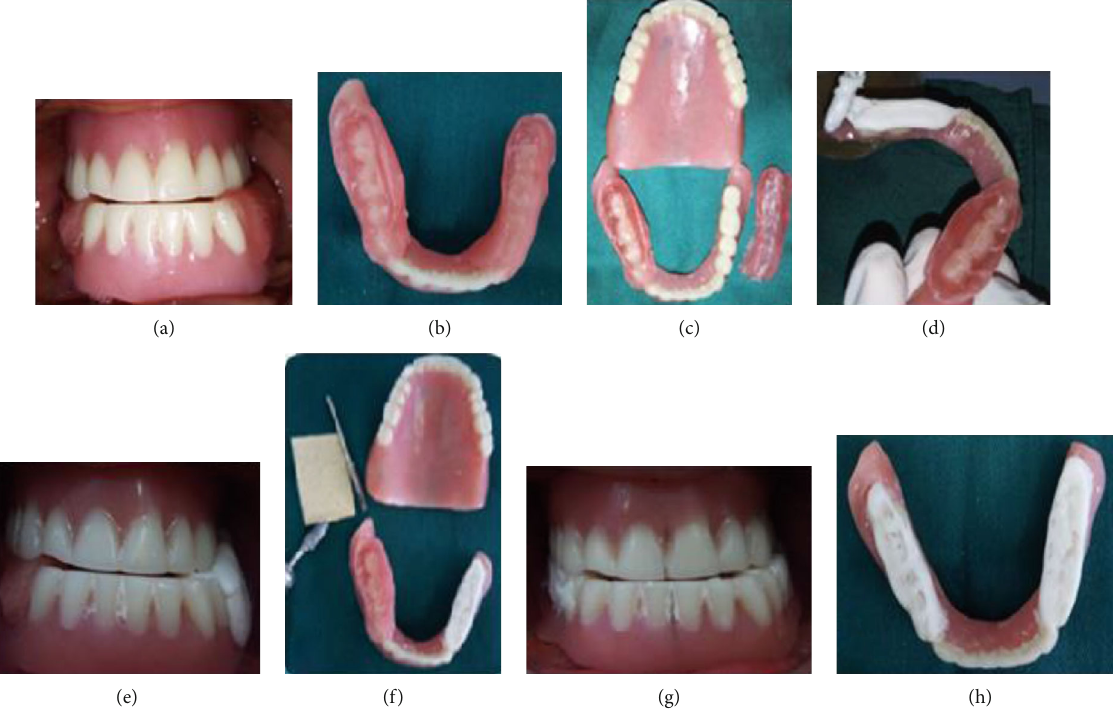
Figure 4: TENCH articulated technique. (a, b) Interocclusal record using wax. (c, d) Replacing the wax with chemopolymerized resin on the right side. (e) Centric relation. (f) Prosthesis polishing. (g, h) Procedure on the right